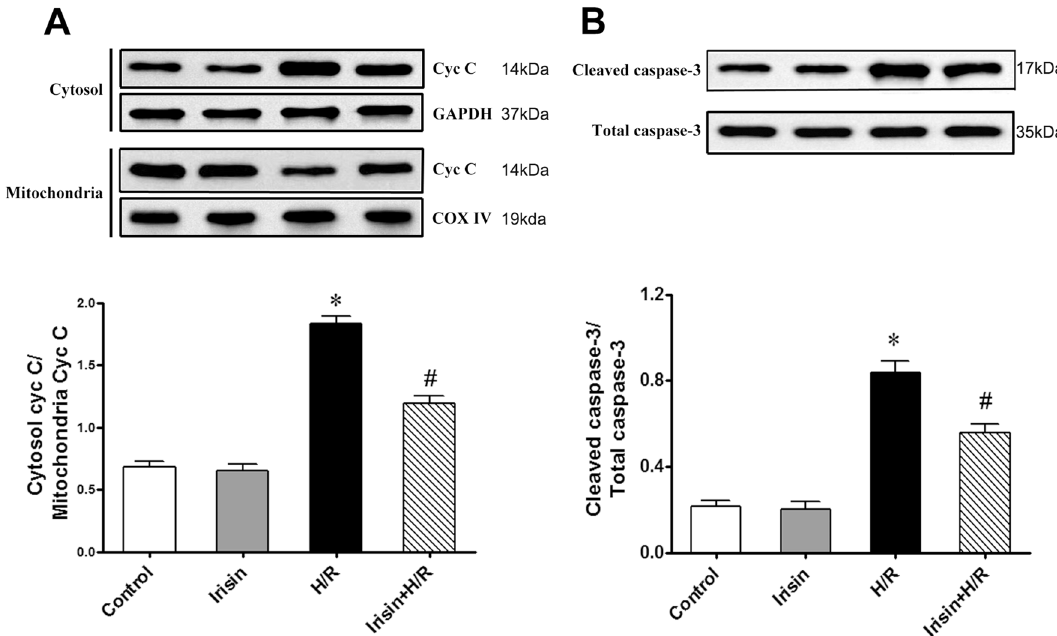
Figure 3. Irisin inhibited H/R-induced cytochrome c release and caspase-3 activation in cardiomyocytes. ( A ) Assessment of cytochrome c (Cyt c) in mitochondria and cytosol derived from cardiomyocytes subjected to H/R. COX IV: Cytochrome c oxidase subunit IV; GAPDH: glyceraldehyde-3-phosphate dehydrogenase. ( B ) Caspase-3 activation in cardiomyocytes subjected to H/R. * P < 0.05 versus control group, # P < 0.05 versus H/R group, n = 6.